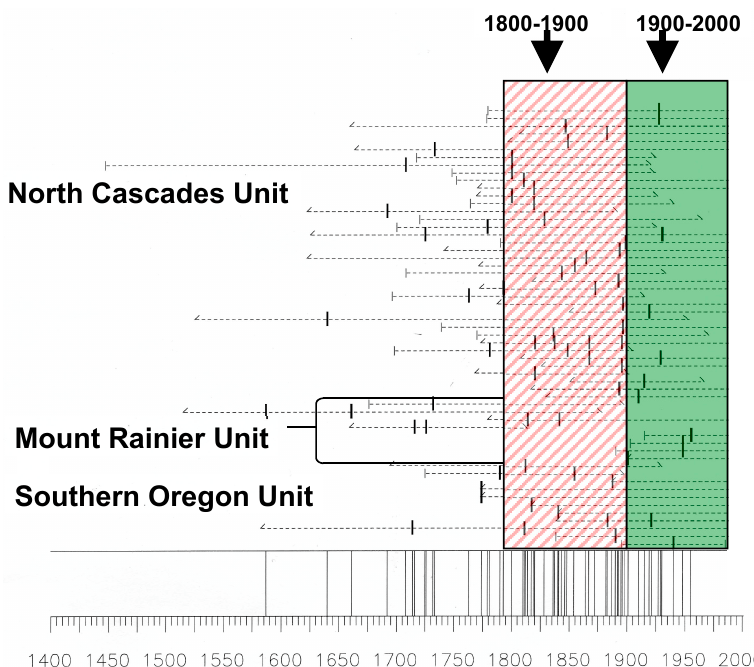
Figure 4. Master fire chronology for fire scar dates from all sites studied. Each horizontal line is an individual fire-scarred tree ring series with each vertical dash representing a dated scar.